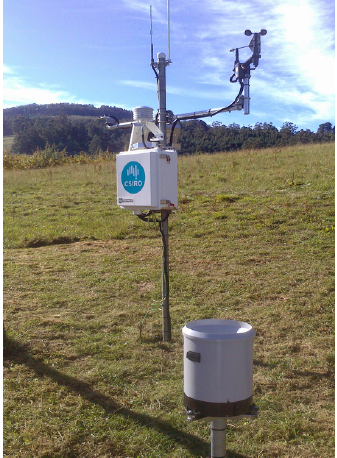
Figure 1. One of the weather stations operated by Commonwealth Scientific and Industrial Research Organisation (CSIRO), deployed in Geeveston (Tasmania, Australia). Similar weather stations are also deployed in other regions in Tasmania, including in South Esk. The instrument is manufactured by Campbell Scientific (model GRWS100) [46] and equipped with a set of sensors to measure several environmental properties: air temperature, relative humidity, barometric pressure, rain fall, solar radiation, wind speed and wind direction. The station also capable of sending the sensed data to a central data repository over 3G connection. Energy is provided by a solar panel.